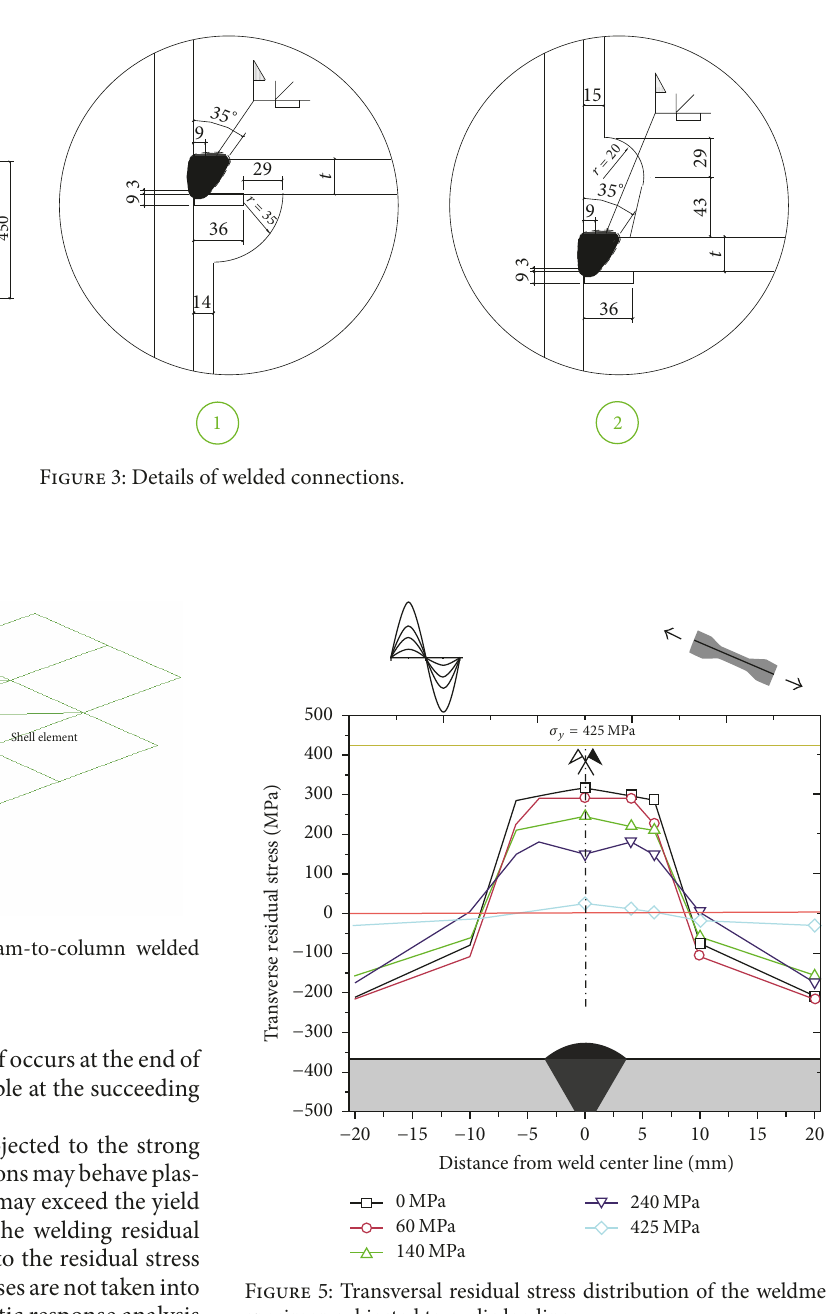
Figure 5: Transversal residual stress distribution of the weldment specimen subjected to cyclic